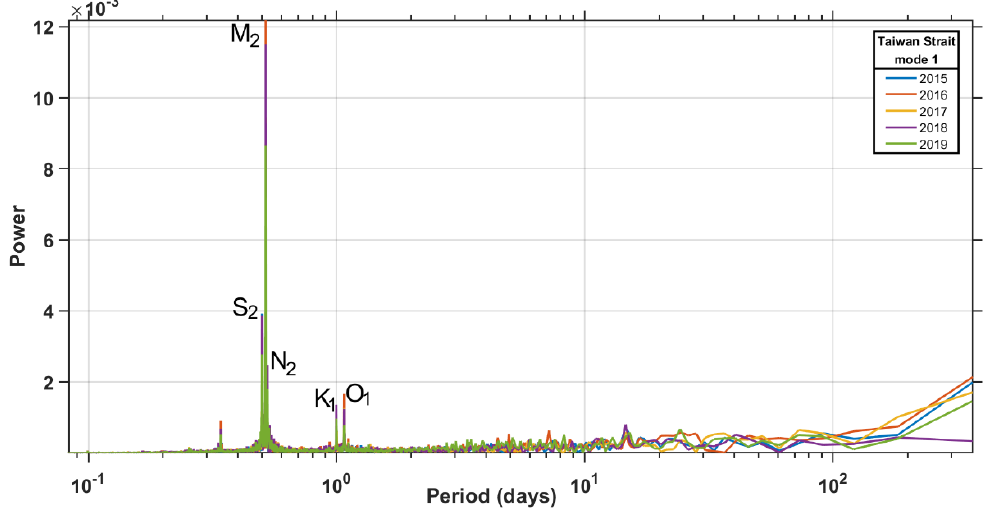
Figure 12. Power spectra of EOF1 principal components of the Taiwan Strait. The sea surface current velocity of the tidal component can be calculated by combining the spatial and temporal values of the EOF1 modes. Table 3 shows the occurrence time and velocity of the maximum tidal current from 2015 to 2019 near the northern tip of the Taiwan Island and around the Penghu Archipelago. They almost all occurred during the spring tide, except in 2019. The maximum tidal current velocity occurred in 2017. These values are relatively stable except for the values in 2019. This is probably because of the long-term lack of data near the northern tip of Taiwan Island that year. The previous study [8] used a harmonic analysis on the measured surface currents from two Ocean State Monitoring and Analyzing Radars (OSMAR) in a small proportion of the Taiwan Strait near the coast of Fujian, China. Its results showed that the M 2 tidal constituent is dominant in that study area. In this study, not only the M 2 tide but also other major tidal constituents were observed. Table 3. The maximum tidal velocity during the ebb tide and flood tide periods. Northern Tip Penghu Northern Tip Penghu Archipelago